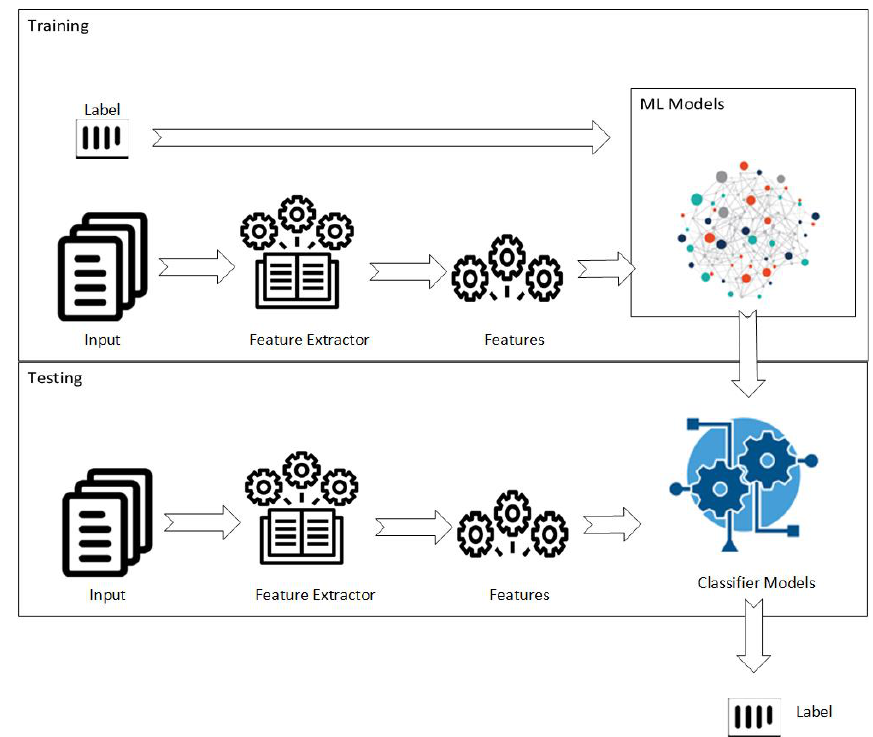
Figure 4. Training and testing of ML